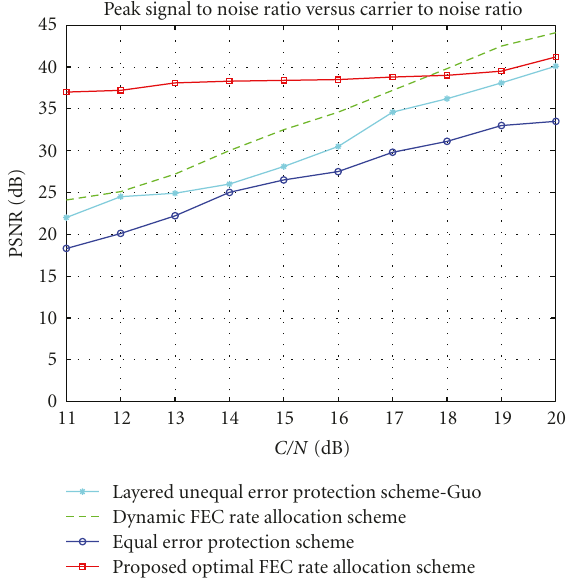
Figure 14: PSNR versus carrier-to-noise